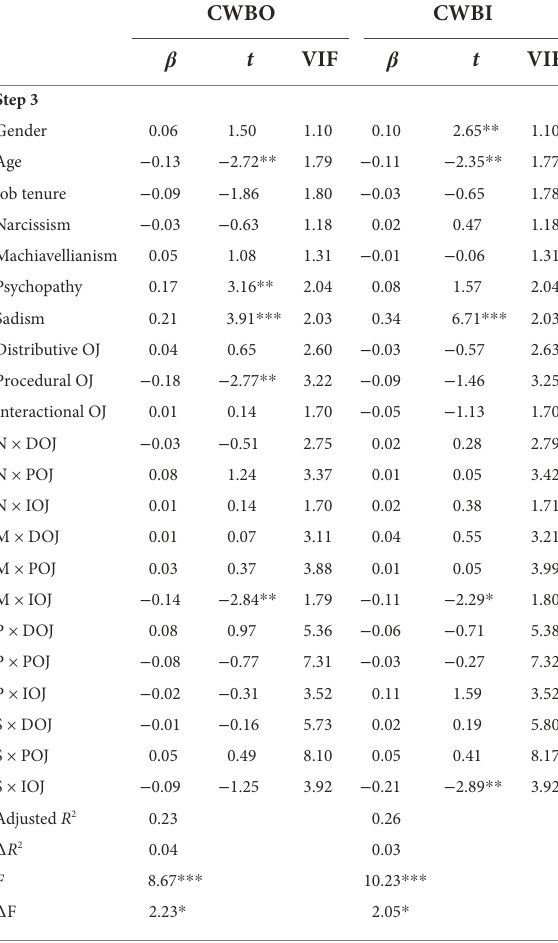
TABLE 3 Hierarchical moderated regression analysis for three types of organizational justice as moderators in the relationships between dark personality traits and